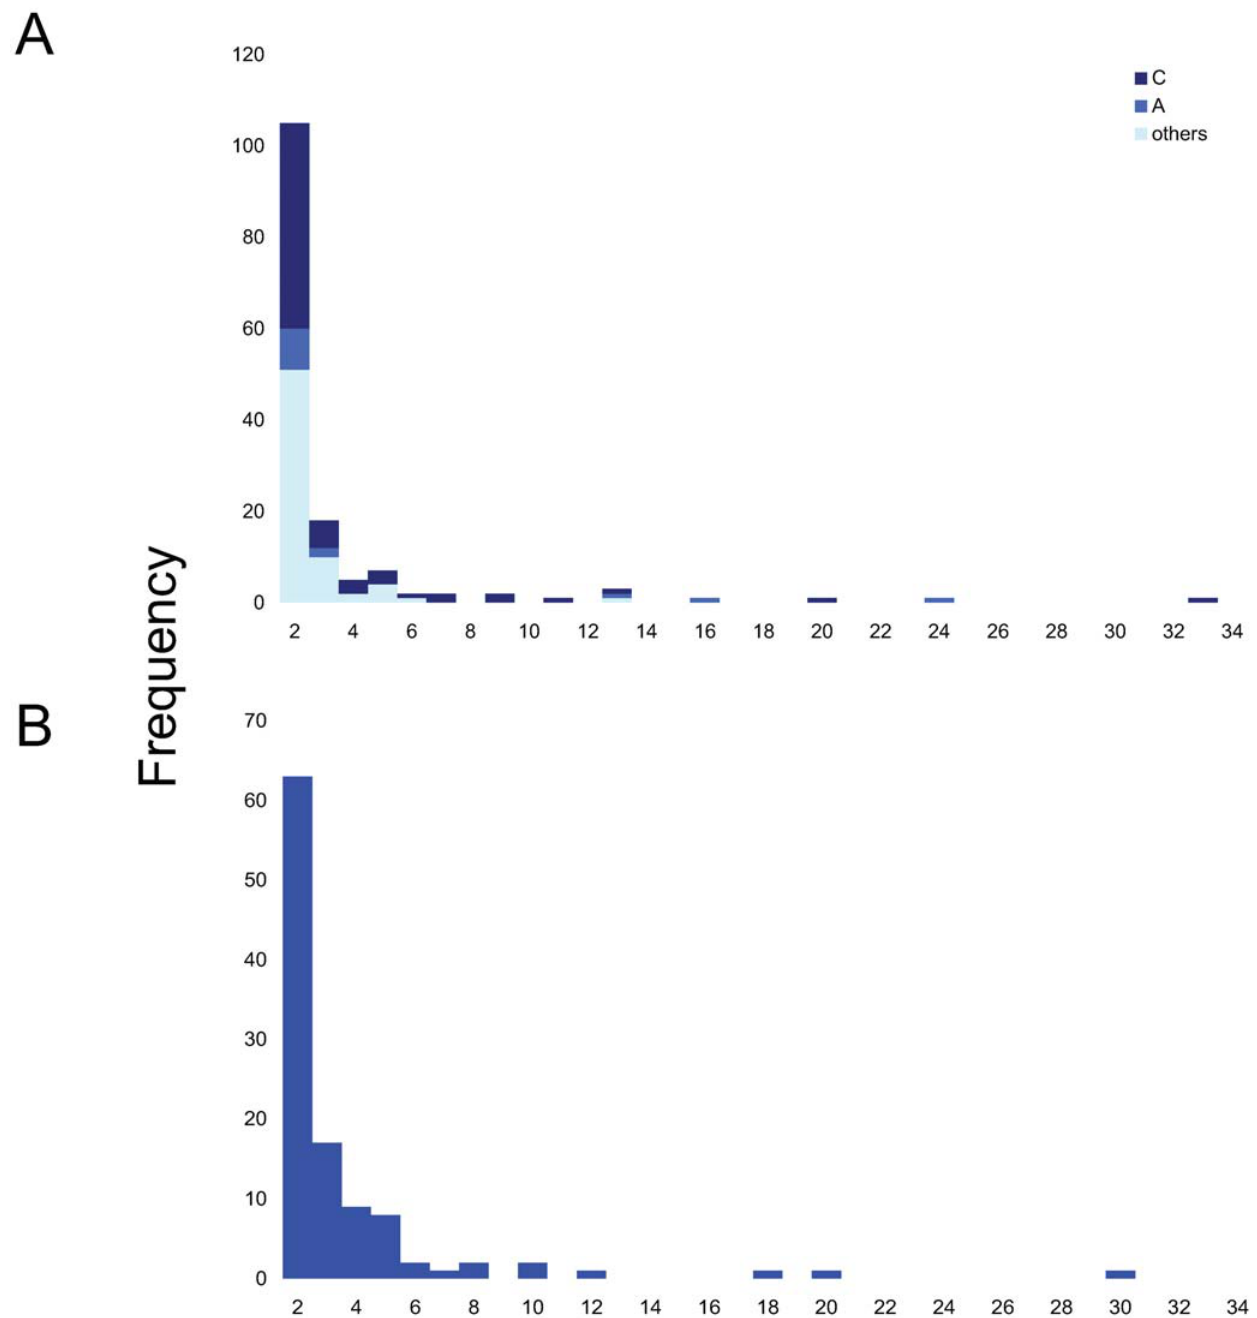
Figure 2. Distribution of cluster size. Frequency of UK-based clusters, as defined in the text, of size 2 or higher, identified by subtype. A) Non-B subtypes (this study). B) Subtype B